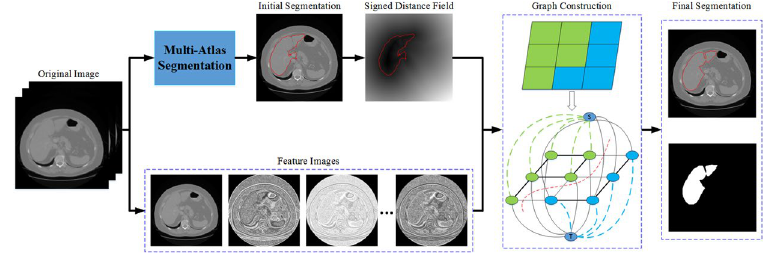
Figure 2. The flowchart of the proposed segmentation framework.